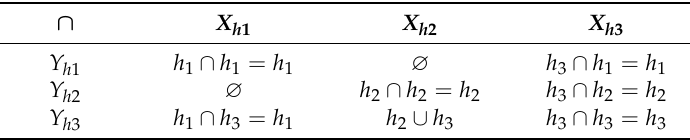
Table 2. BBA fusion for appliances X and Y.